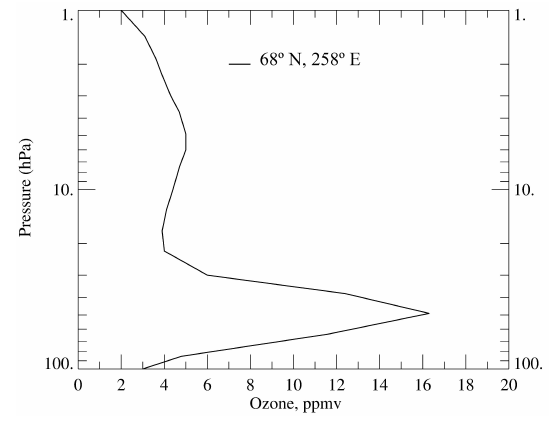
Figure 1. LIMS V5 ozone mixing ratio profile at 68 ◦ N, 258 ◦ E on 11 January 1979, showing effects of uncorrected emissions from PSCs below about the 20hPa